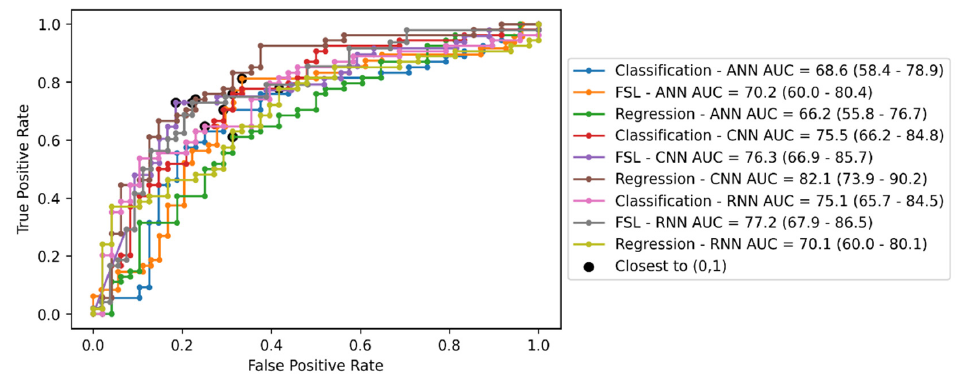
Figure 2. The ROC curve, AUC score, and the closest point to (0, 1) for all approaches. Values in the parentheses represent the 95% confidence intervals computed as in [65]. The performance and statistics of the various ensemble DL models and approaches considered herein are displayed in Table 3. Table 3. Diagnostics and performance statistics of the considered ensemble DL models and ap- proaches. Values in the parentheses represent the 95% confidence intervals.